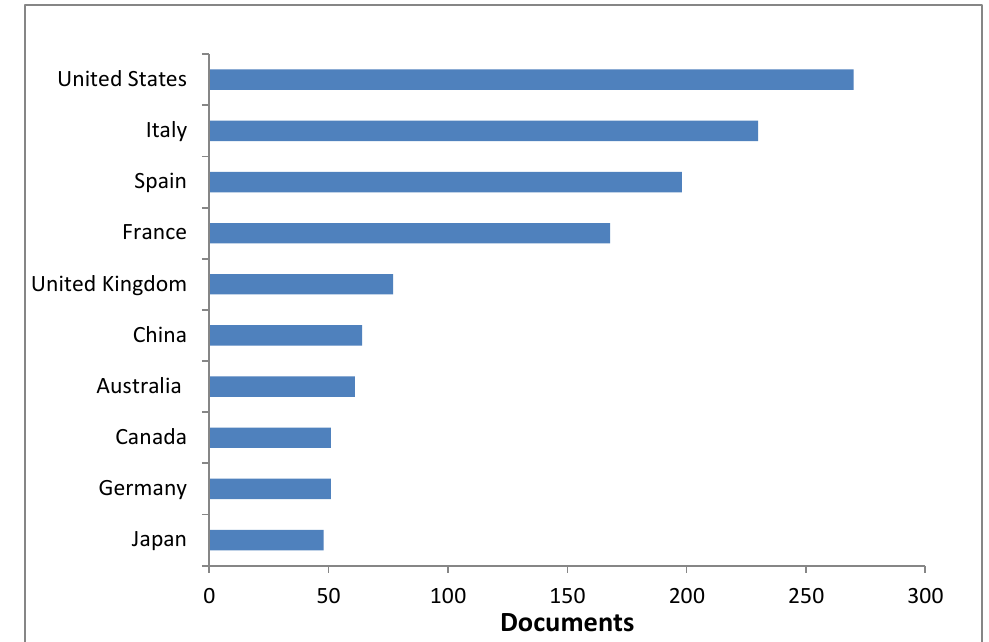
Figure 6. Most productive countries. (Bibliometric data were extracted from the Scopus online database).